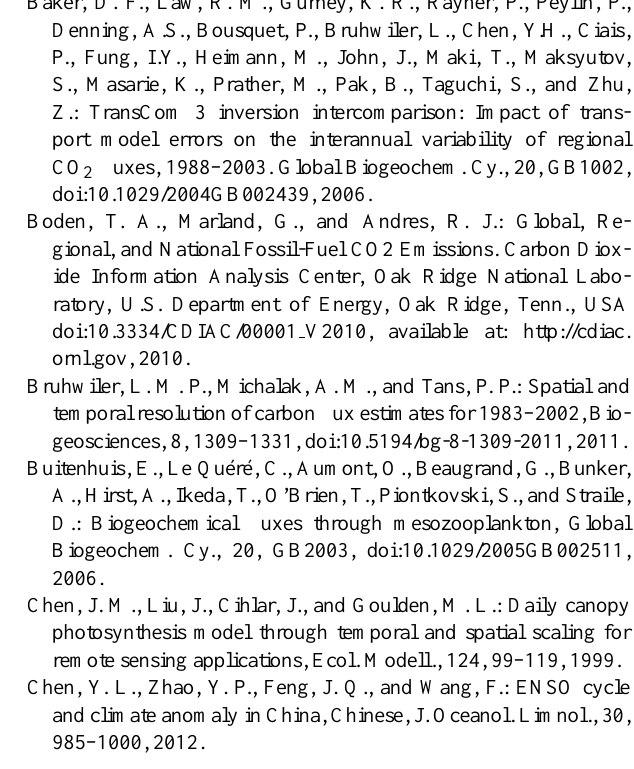
Fig. 9. Carbon budget in China (PgC yr -1 )